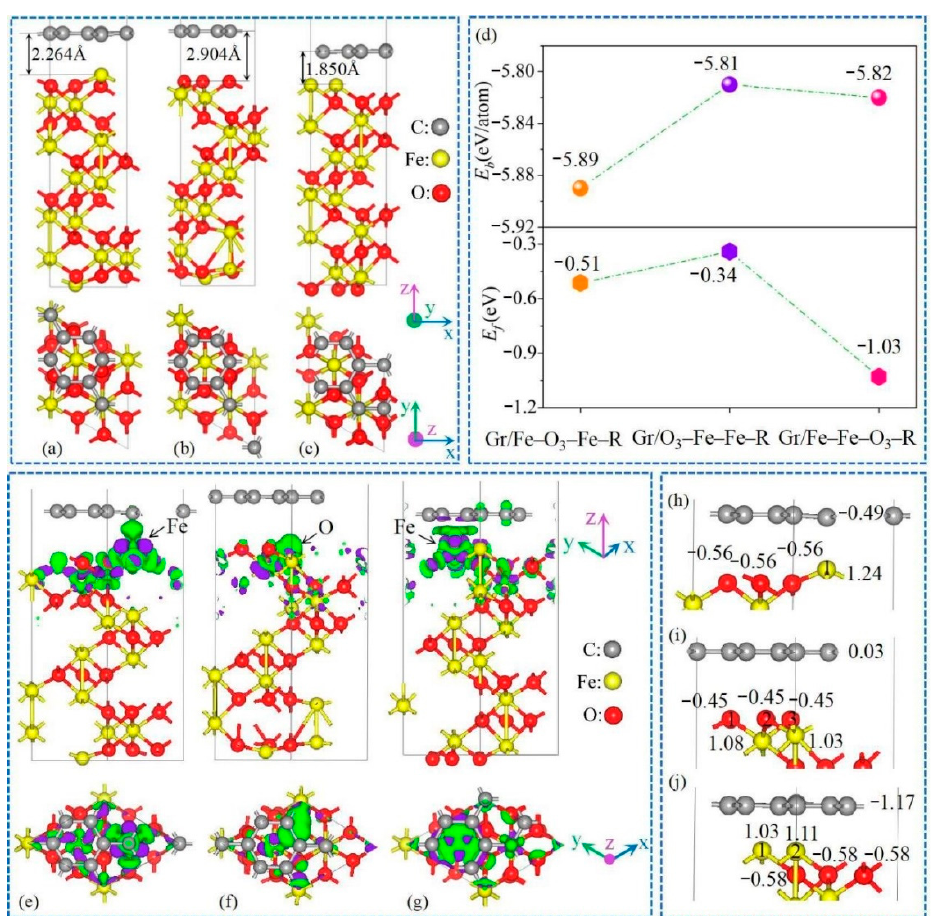
Figure 1. Optimized geometries of ( a ) Gr/Fe-O 3 -Fe-R, ( b ) Gr/O 3 -Fe-Fe-R, and ( c ) Gr/Fe-Fe-O 3 -R heterostructures; ( d ) bind- ing energy ( E b ), interfacial formation energy ( E f ), and ( e – g ) charge difference plots of three models (isosurface level was set to 0.04 electrons/bohr 3 , green and purple areas represent charge accumulation and depletion); ( h – j ) transferred elec- trons of atoms near the interface in ( h ) Gr/Fe-O 3 -Fe-R, ( i ) Gr/O 3 -Fe-Fe-R, and ( j ) Gr/Fe-Fe-O 3